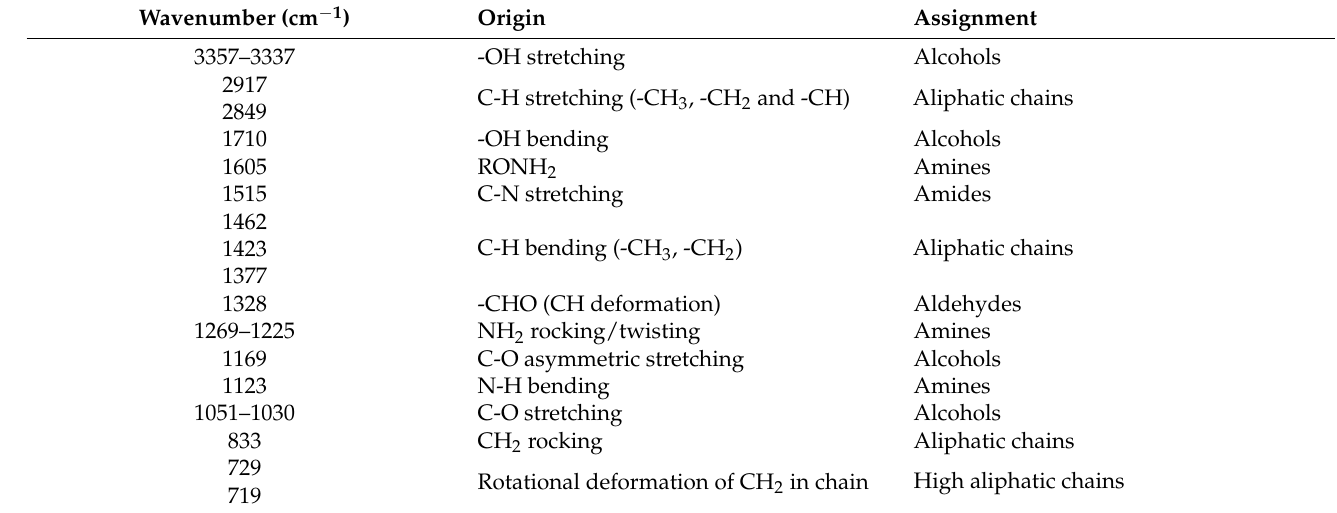
Table 5. FTIR frequencies interpretation table.